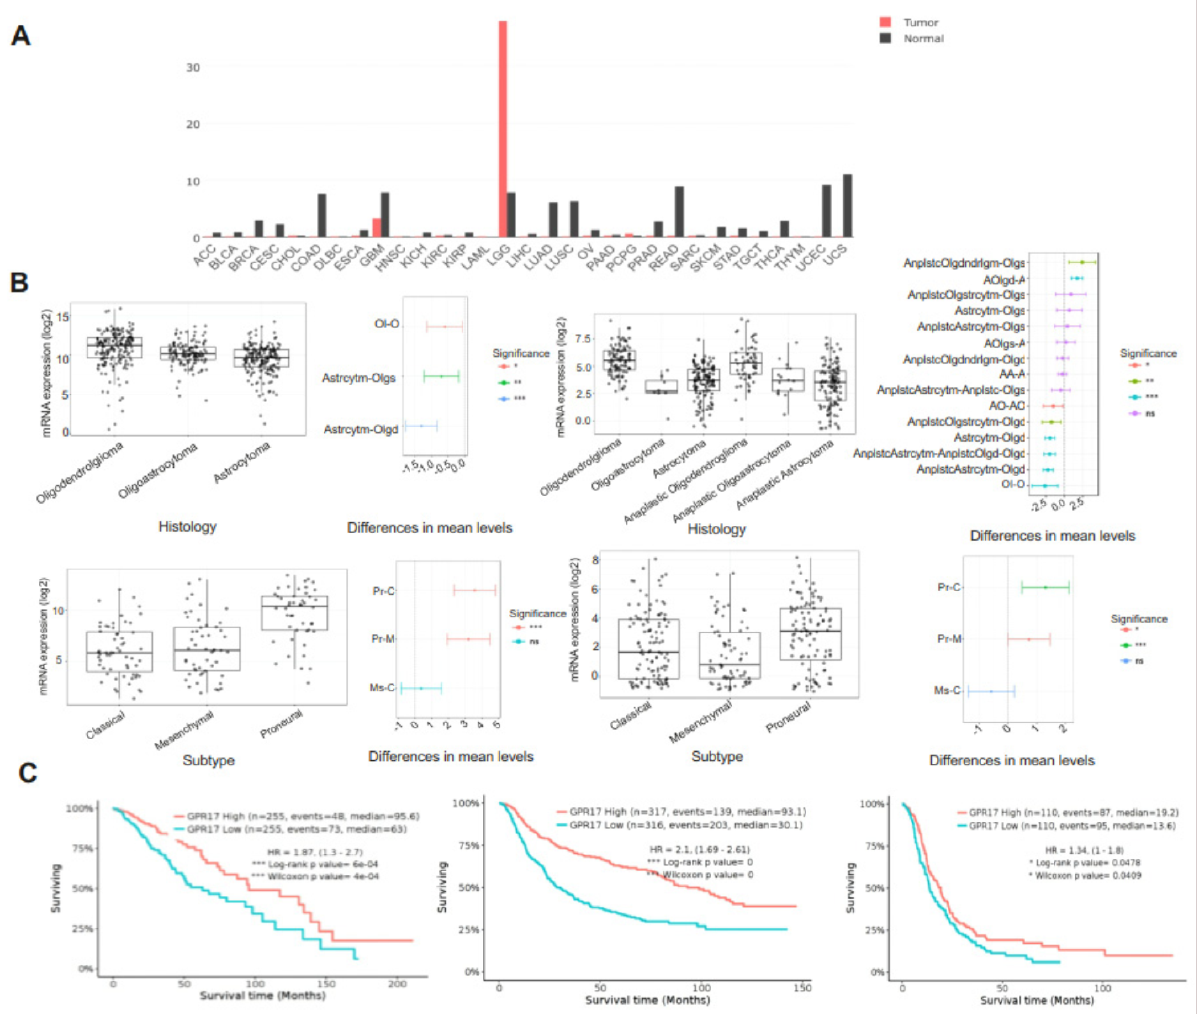
Figure 1. GPR17 as a biomarker in histological subtypes of glioma. ( A ) GPR17 expression profile across all tumor samples and paired normal tissues. ( B ) GPR17 expression in histological subtypes of glioma. ( C ) Overall survival associated with GPR17 expression in the TCGA LGG dataset, CGGA primary glioma dataset, and CGGA primary GBM dataset; survival time is represented in